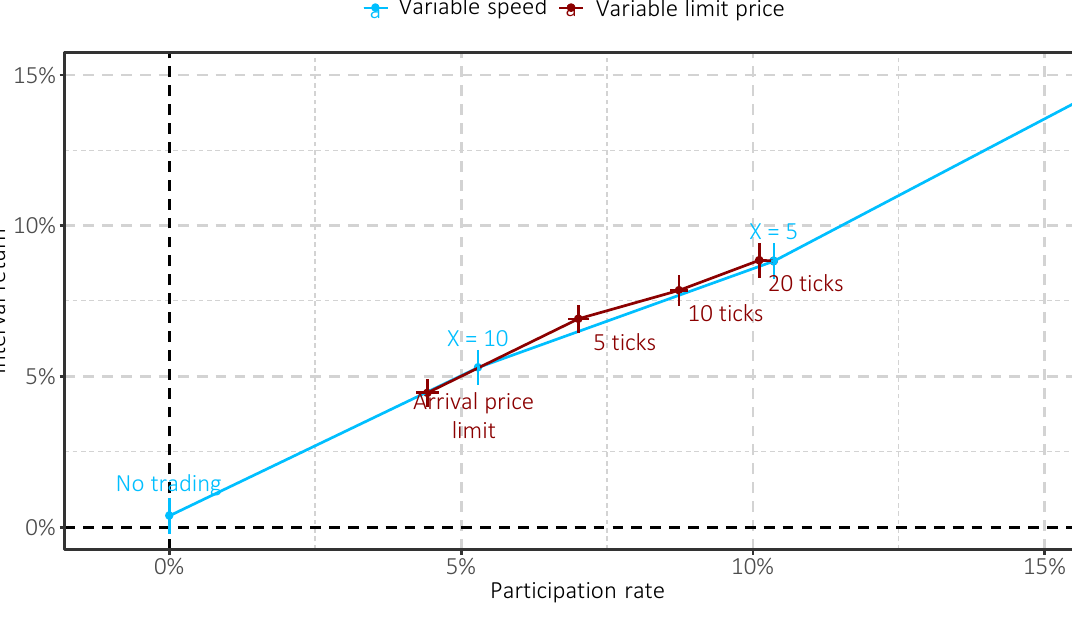
Figure 8. Market impact for various speed of trading and limit prices